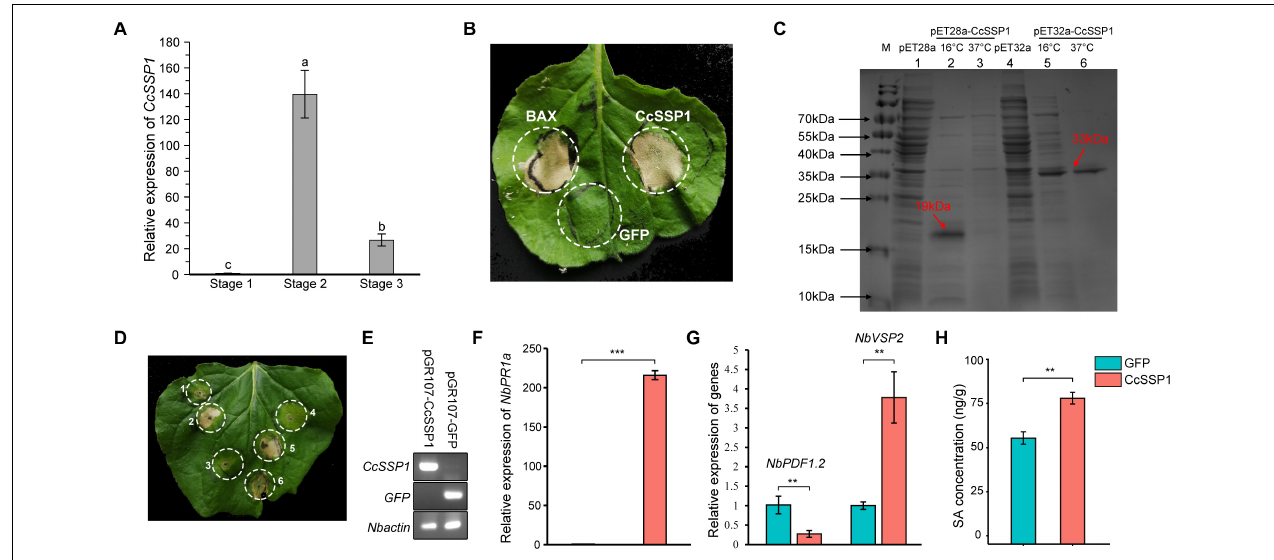
FIGURE 5 | CcSSP1 induces tobacco cell death and activates the salicylic acid signaling. (A) CcSSP1 was up-regulated during the process with Ciboria carunculoides infecting mulberries. CcActin was used as an internal reference gene. Letters a, b indicate statistical differences, n = 3, P < 0.05. (B) CcSSP1 induced cell death in Nicotiana benthamiana . Leaves of N. benthamiana were transformed with indicated constructs by agro-infiltration. Photographs were taken 6 d post agroinfiltration. (C) Prokaryotic expression of CcSSP1. The recombinant CcSSP1 is marked with arrows. (D) The supernatant of prokaryotically expressed CcSSP1 induced cell death in N. benthamiana . 1, supernatant from empty pET28a vector; 2–3, supernatant from pET28a-CcSSP1 induced at 16 and 37 ◦ C, respectively; 4, supernatant from empty pET32a vector; 5–6, supernatant from pET32a-CcSSP1 induced at 16 and 37 ◦ C, respectively. Photographs were taken 5 days after infiltration with recombinant proteins. Results are representative of three biological replicates. (E) Semi-quantitative measurement of the transcription of CcSSP1 and GFP transiently expressed in N. benthamiana . (F) After transient expression of CcSSP1 and GFP , the relative expression of the SA defense signal marker NbPR1a in N. benthamiana . (G) After transient expression of CcSSP1 and GFP , the relative expression of the JA signaling pathway markers NbPDF1.2 and NbVSP2 in N. benthamiana . The transcript levels were monitored by quantitative reverse transcription PCR. NbActin was used as an internal reference gene. The q-PCR analyses were repeated at least three times. (H) Measurement of the SA content in N. benthamiana a fter transient expression of CcSSP1 or GFP. The leaf samples in (E–H) were collected 2 days after Agrobacterium infiltration. Each treatment contains three technical replicates, and each technical replicate sample uses two leaves. Asterisks indicate a statistically significant difference (** P < 0.01, *** P < 0.001) based on Student’s t